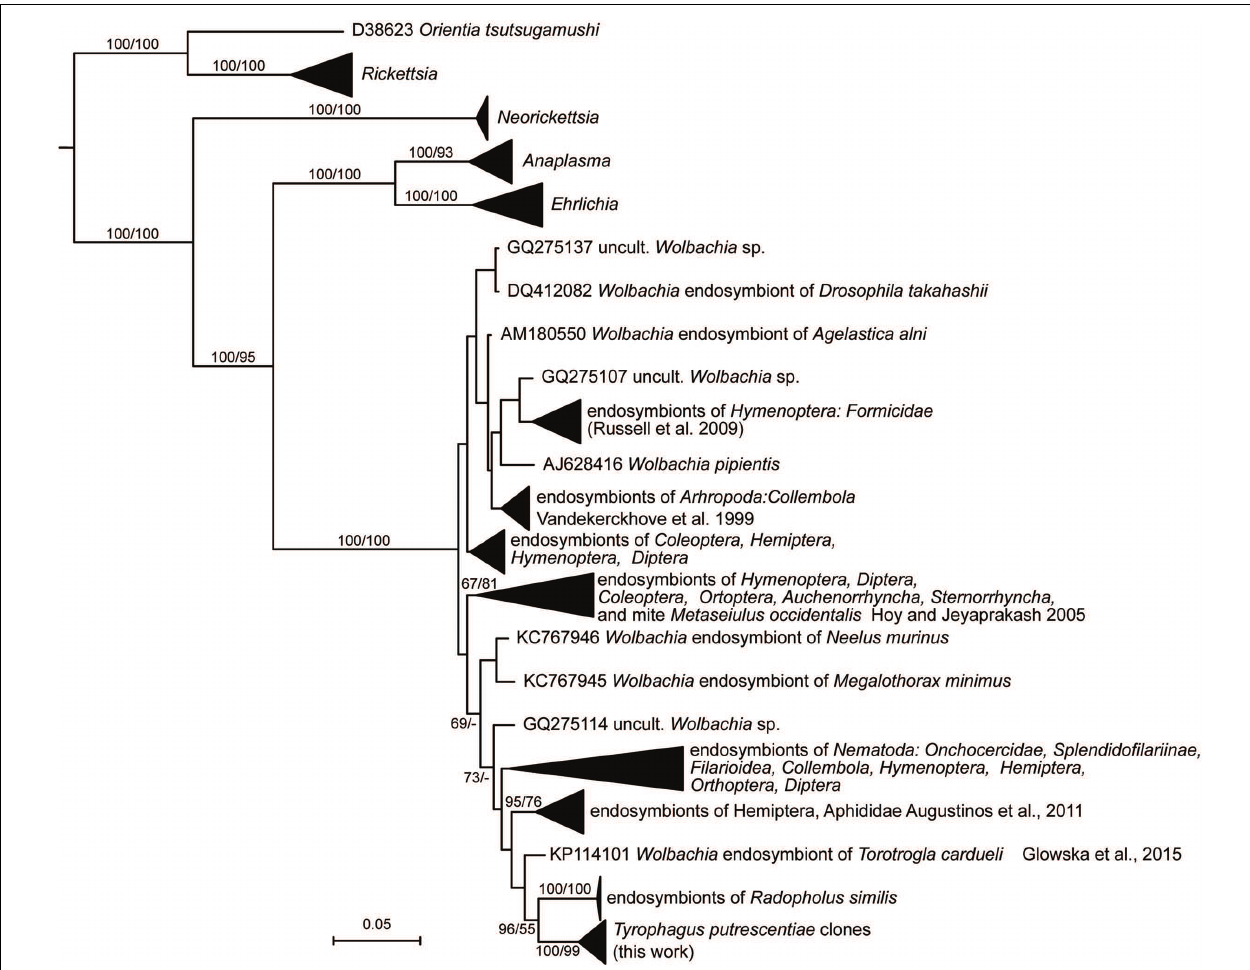
FIGURE 4 | Phylogenetic analysis of the Wolbachia clones obtained from the Dog and Phillips populations of T. putrescentiae . The phylogeny was inferred by a Bayesian analysis of 19 partial 16S rRNA gene sequences cloned from T. putrescentiae with the reference sequences from RDP, 242 known Wolbachia endosymbionts (Vandekerckhove et al., 1999; Hoy and Jeyaprakash, 2005; Haegeman et al., 2009; Russell et al., 2009; Augustinos et al., 2011; Glowska et al., 2015) and 27 type strains of the order Rickettsiales . Branch lengths correspond to the mean posterior estimates of evolutionary distances (scale bar: 0.05). Branch labels indicate Bayesian posterior probabilities and bootstrap support values for maximum likelihood analysis. The phylogram was rooted using Rhizobium oryzae sequence EU056823 as an